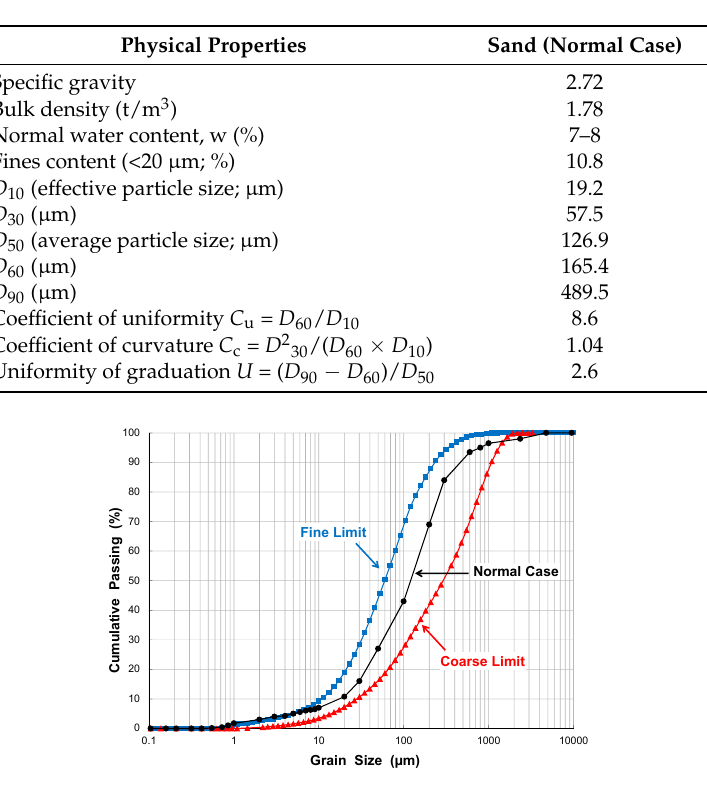
Table 1. Physical properties of the utilized alluvial sand in backfill.